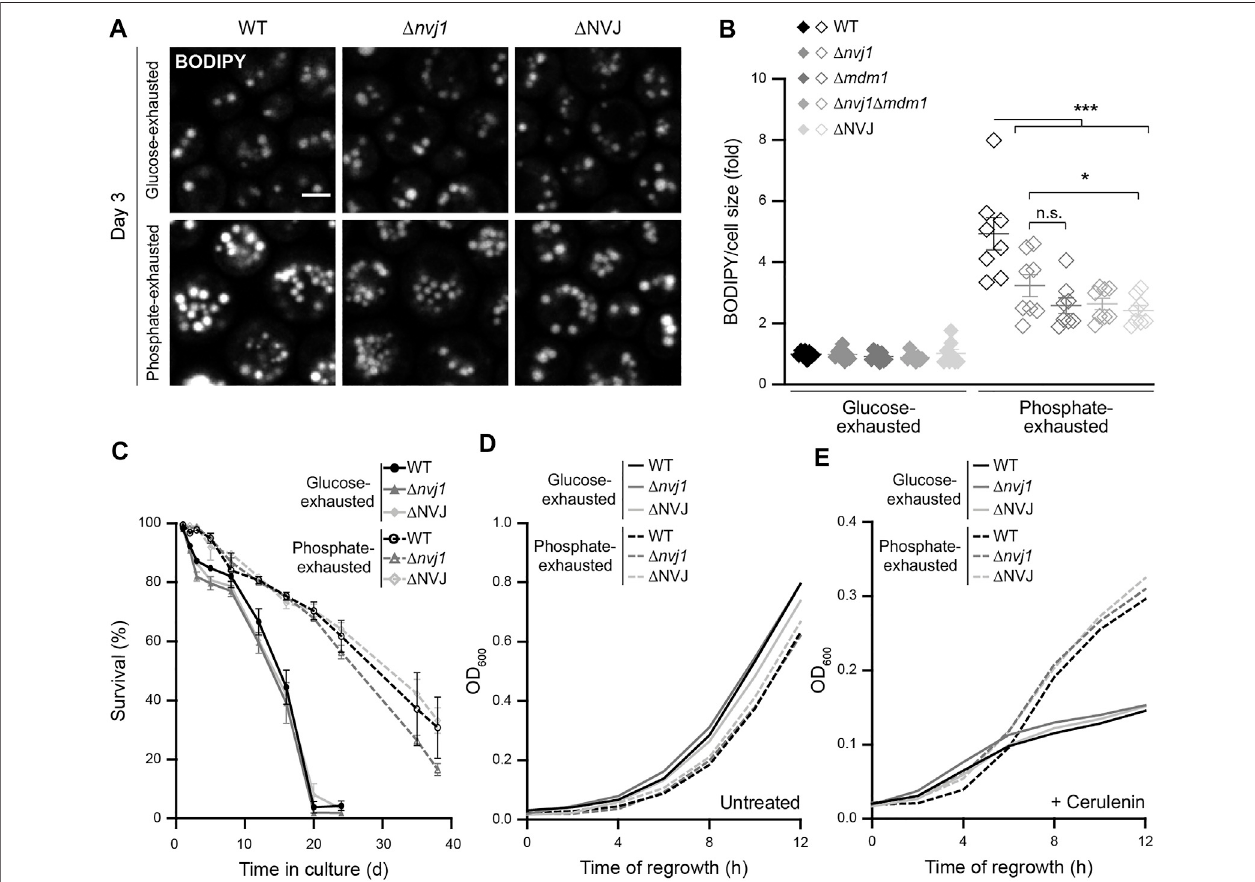
FIGURE 4 | NVJs support LD biogenesis induced by phosphate exhaustion (A) Confocal micrographs of BODIPY-stained WT (BY4741), Δ nvj1 , and Δ NVJ cells upon glucose or phosphate exhaustion at day 3. Scale bar: 2 μ m (B) Flow cytometric quanti fi cation of neutral lipid content via BODIPY in WT, Δ nvj1 , Δ mdm1, Δ nvj1 Δ mdm1 and Δ NVJ cells after 3 days of glucose or phosphate exhaustion. BODIPY mean fl uorescence intensity was normalized to cell size and data is shown as foldofrespectiveglucose-exhaustedcells;Mean±SEM;n=8 (C) SurvivalofWT, Δ nvj1 ,and Δ NVJcellsduringchronologicalaging,determinedvia fl owcytometric quanti fi cation of propidium iodide staining at indicated time points after glucose or phosphate exhaustion. n = 4 (D,E) Regrowth of cells described in (C) after 3 days of glucose or phosphate exhaustion. Nutrient-exhausted cells were re-inoculated in unrestricted, fresh standard medium and OD 600 was monitored every 2 h. Cells were left untreated (D) or were treated with 1 µM cerulenin at the time point of re-inoculation (E); n = 4. For more details in respect to statistical analyses, please see Supplementary Table S4 .